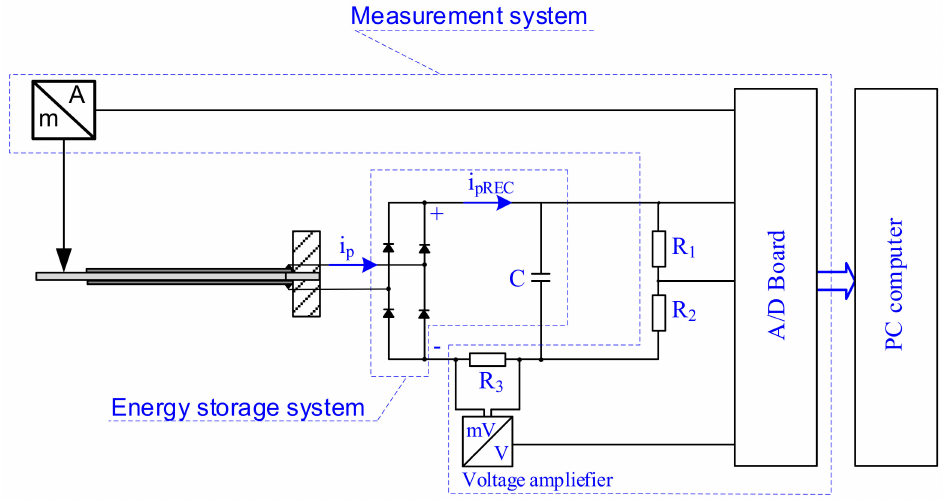
Figure 4. Structure of storage system and measurement system.